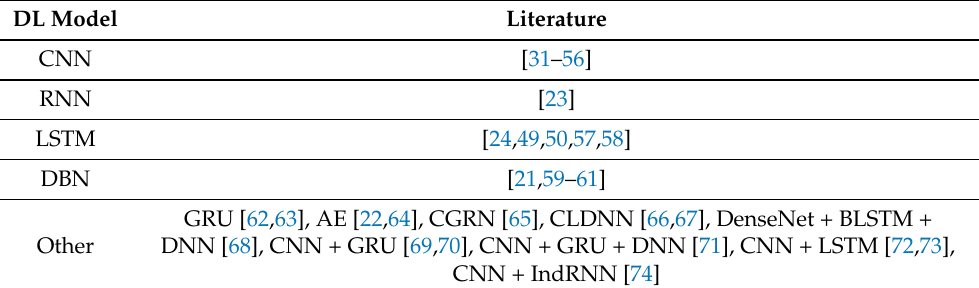
Table 1. Applications of DL models in radio modulation